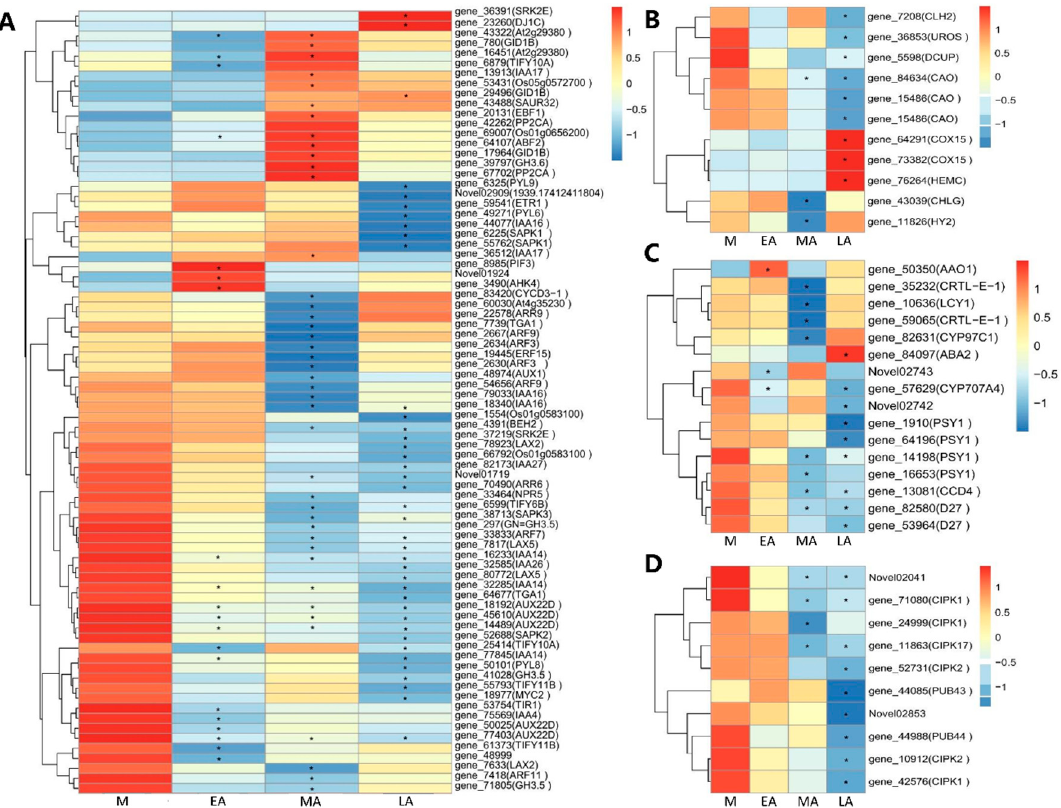
Figure 5. Expression patterns of DEGs in different KEGG pathways. ( A ) Plant hormone signal transduction. ( B ) Porphyrin and chlorophyll metabolism. ( C ) Carotenoid biosynthesis. ( D ) Regulation of autophagy. * represents a significant difference of gene expression levels at p ≤ 0.05 compared with M. The x -axis refers to each stage of premature senescence. The y -axis indicates gene expression levels. Log 10 (FPKM + 1) was used for the heat map to normalize the gene expression level. Blue and red represent low and high gene relative expression levels respectively.